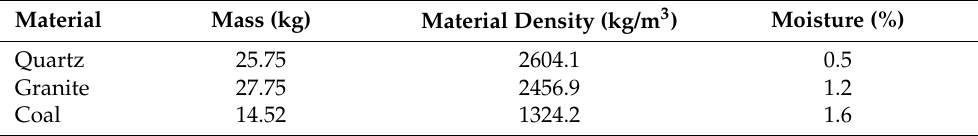
Table 2. Mass, material density, and moisture of the samples of quartz, granite and